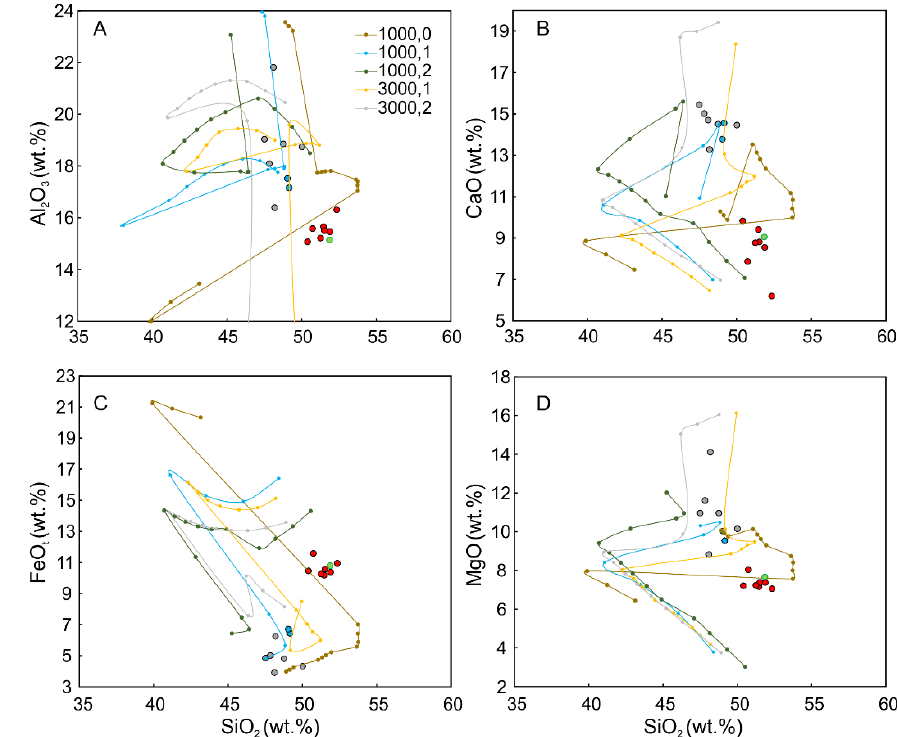
Figure 9. Accumulation modelling by rhyolite ‐ MELTS of ( A ) SiO 2 vs Al 2 O 3 , ( B ) SiO 2 vs CaO, ( C ) SiO 2 vs FeO t , and ( D ) SiO 2 vs MgO. The initial melt composition is 14HC ‐ 3 ‐ 3 and fractional crystallization is adopted. The accumulation trend for each of the five models (1 kbar ‐ 0% water, 1 kbar ‐ 1% water, 1 kbar ‐ 2% water, 3 kbar ‐ 1% water, 3 kbar ‐ 2% water) represents the instantaneous crystal assemblage with 5% intervals and it starts from 5% to 70% crystallization.